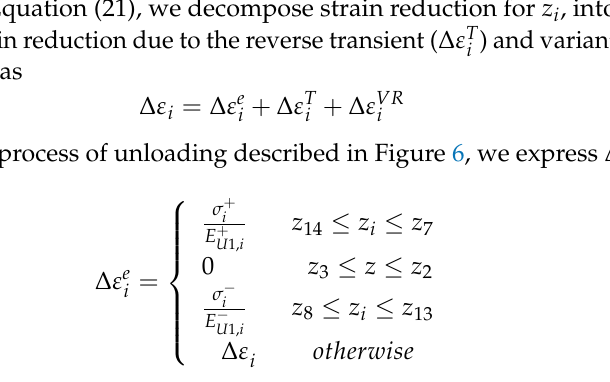
Figure 6. Stress–strain curve for SMA beam at low temperature upon unloading.